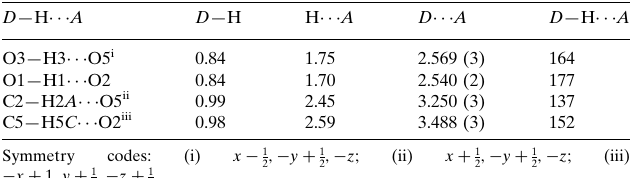
Hydrogen-bond geometry (A˚ , (cid:4)